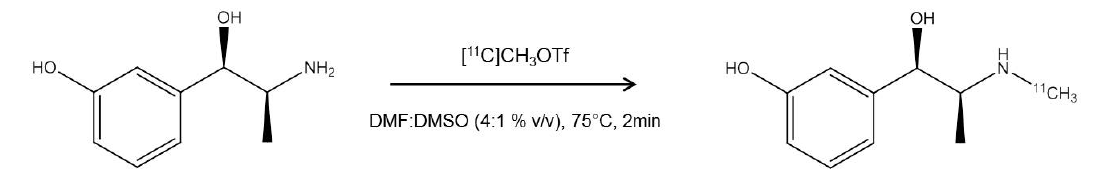
Figure 7. Reaction scheme of the radiosynthesis of [ 11 C] m HED.